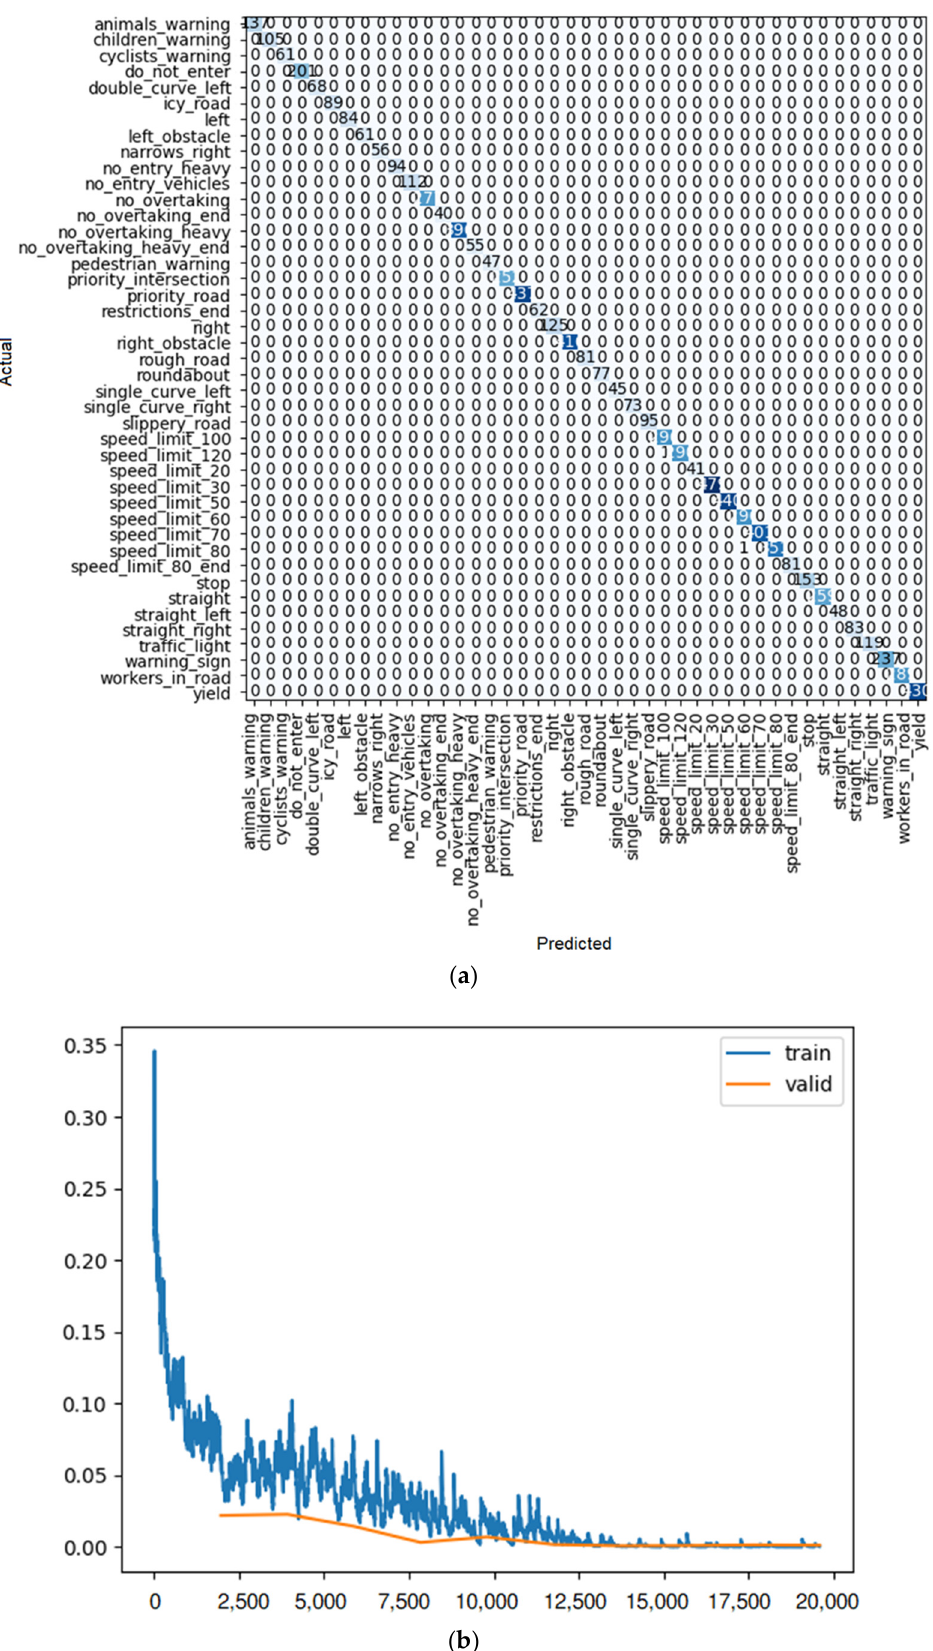
Figure 21. ( a ) Confusion matrix and ( b ) loss rate during training with DenseNet 201.